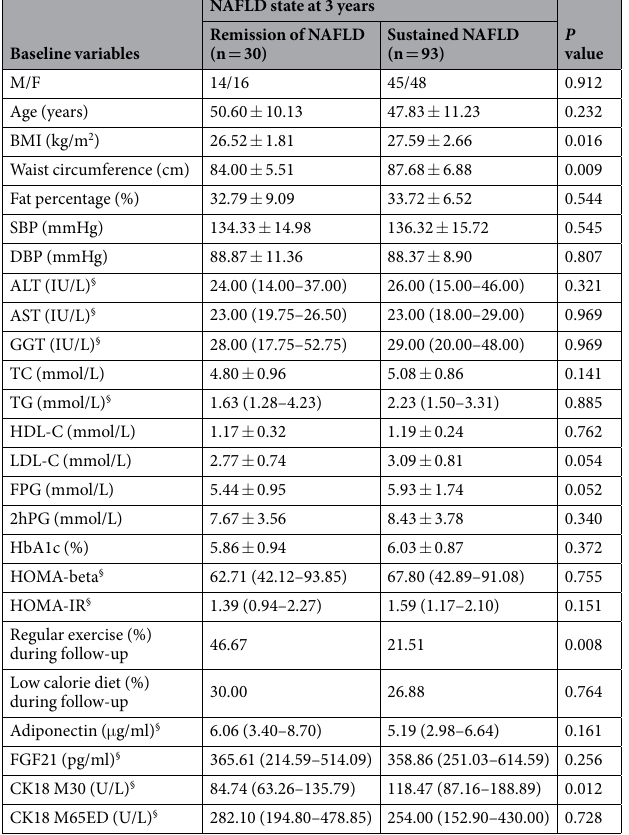
rarely detected in patients with simple steatosis or patients without NAFLD.